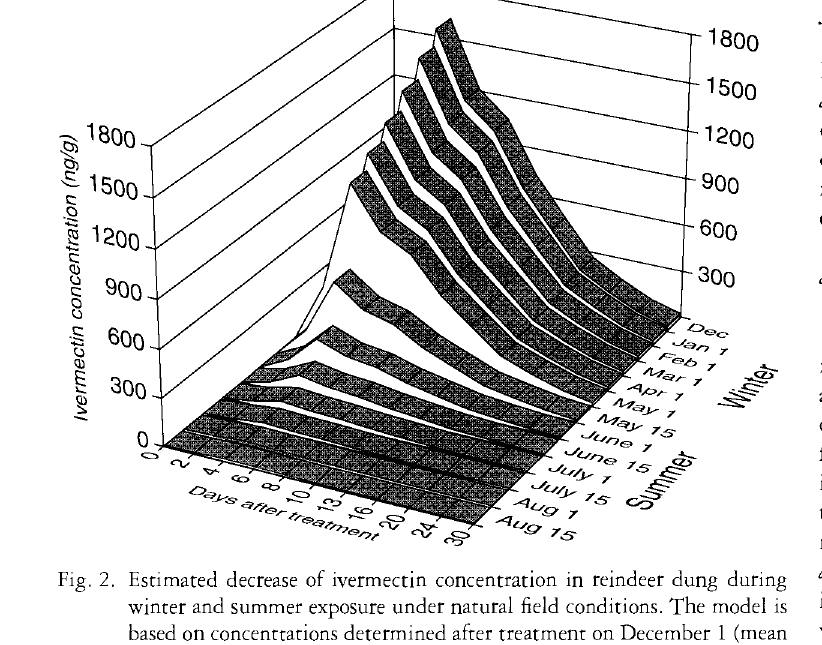
Fig. 2. Estimated decrease of ivermectin concentration in reindeer dung daring winter and summer exposure under natural field conditions. The model is based on concenttations determined after treatment on December 1 (mean profile in Fig. 1) and half-lives of 217 and 14 days in winter and summer (after May 1),